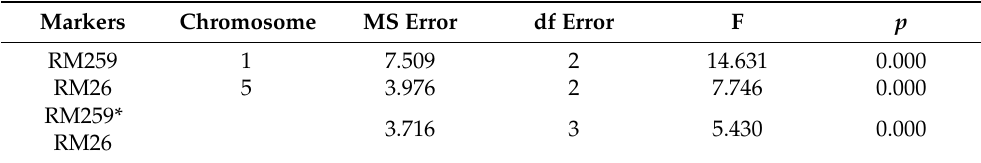
Table 4. Two-way ANOVA using one marker locus from each of the two putative regions related to stem branch